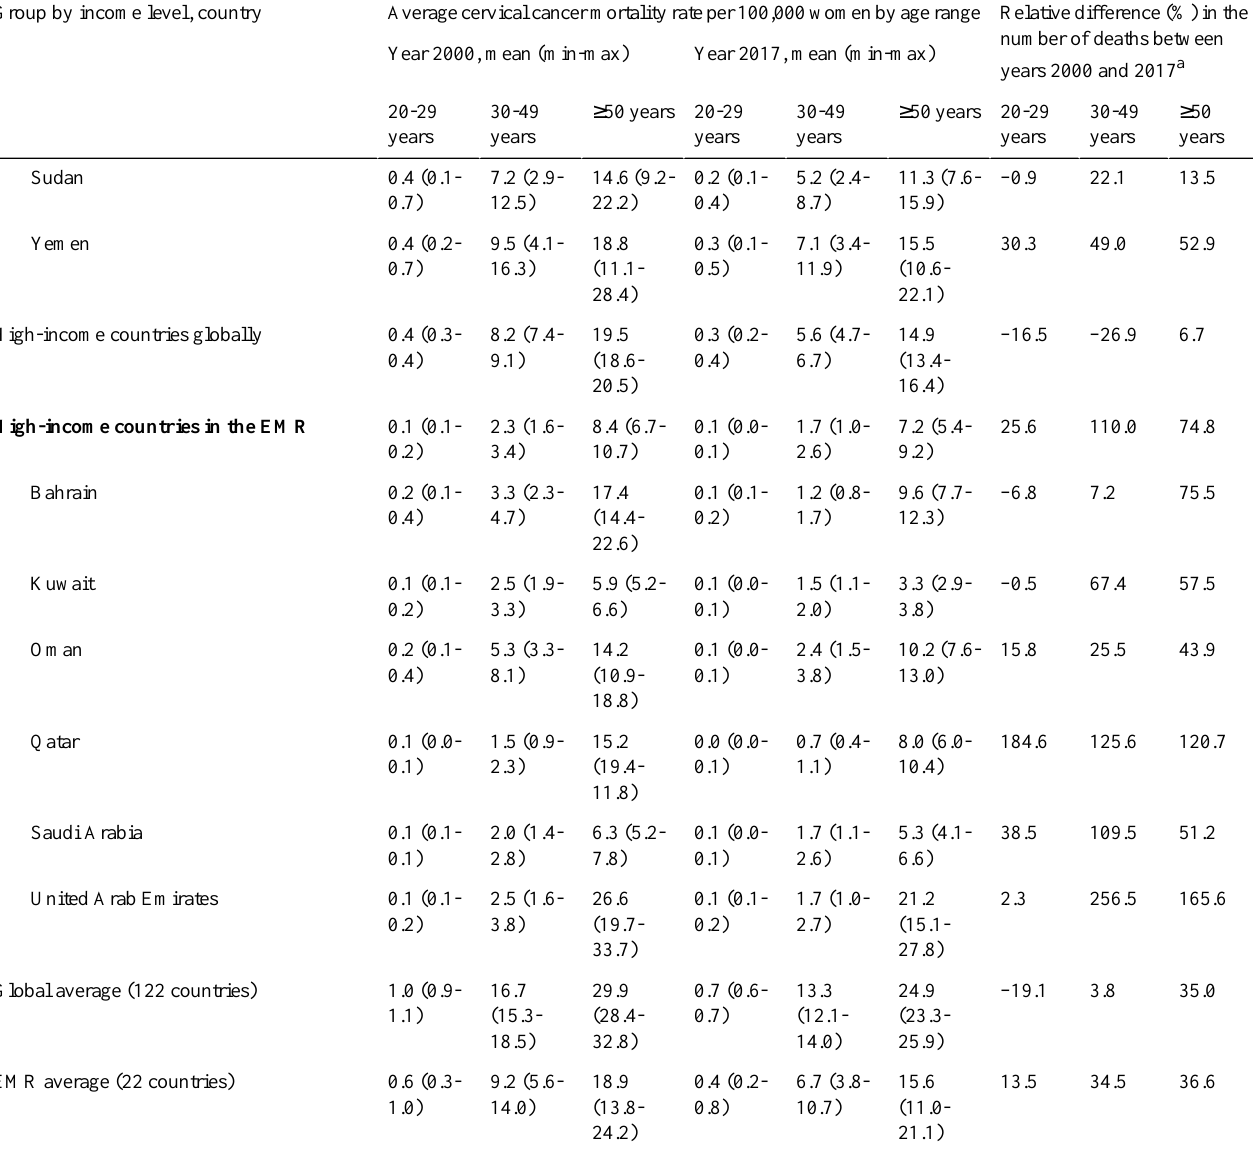
a Relative difference (%) in the number of deaths = ([number of cervical cancer deaths in 2017 – number of cervical cancer deaths in 2000]/number of cervical cancer deaths in 2000)*100. b EMR: Eastern Mediterranean